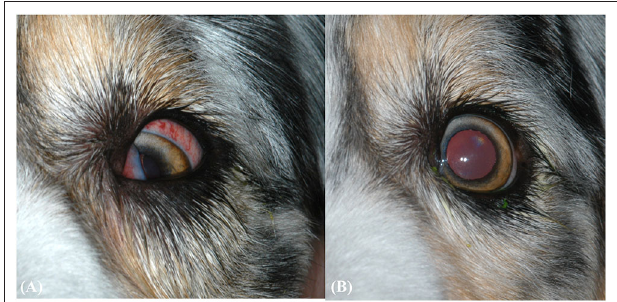
FIGURE 1 | (A) Clinical ophthalmic findings at the second ophthalmic examination. Findings include protrusion of the third eyelid, ventromedial strabismus, and episcleral hyperemia. (B) Clinical ophthalmic findings after 1 month of oral amoxicillin/clavulanic acid for pyogranulomatous myositis. The eye has returned to normal positioning, but positional ventral strabismus remains during dorsal extension of the neck (not